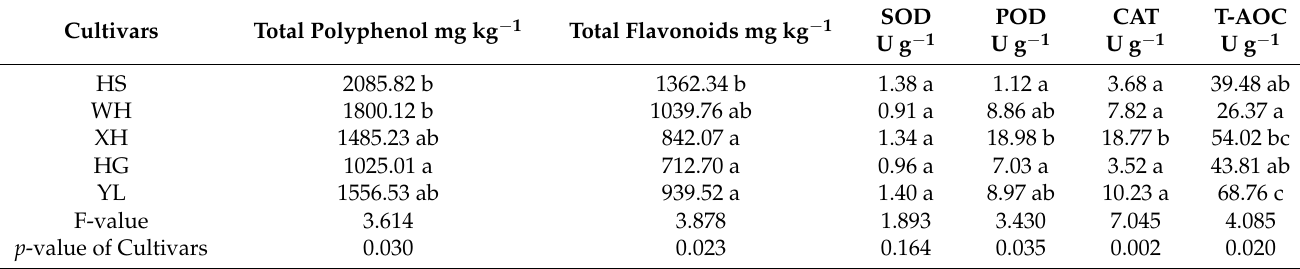
Different letters after the digital represent significant differences, shared letters represent no significant